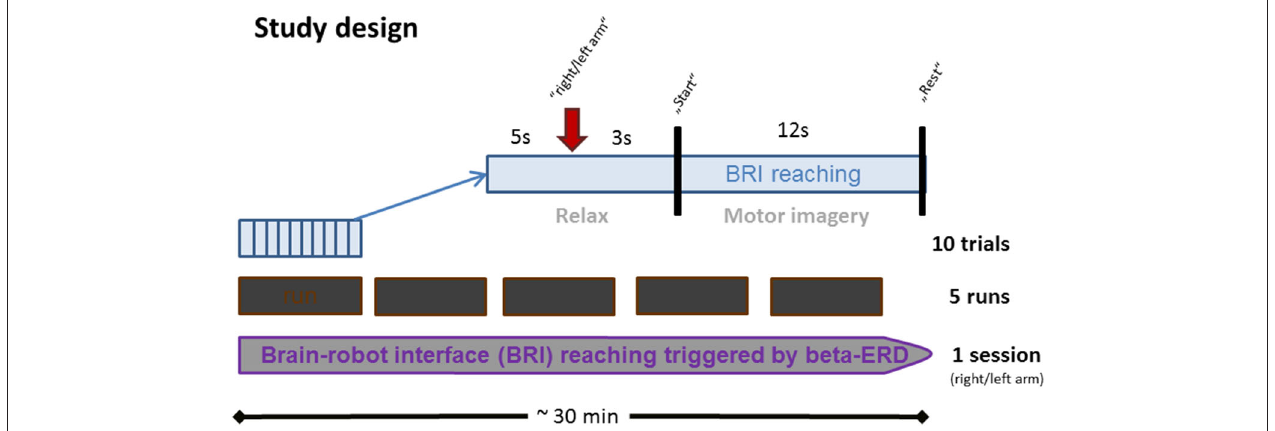
FIGURE 1 | Time course of BRI session. Each BRI session lasted for approximately 30 min and consisted of five runs which were interrupted by four short breaks. Every run consisted of 10 trials, each lasting 20 s. In each trial, subjects were instructed to prepare for MI upon an auditory cue (3 s preparation phase), and to imagine the respective reaching movement upon a “start” cue (12 s MI phase). This was followed by a “rest” cue (5 s rest